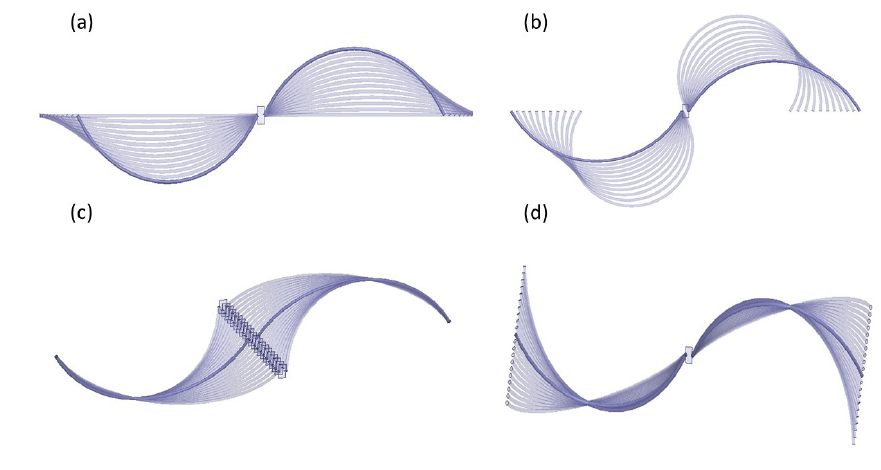
Figure 4. Schematic representation of the induced deformations applied to the spiral fiber antenna: ( a ) stretching, ( b ) compressing, ( c ) bending, and ( d ) folding. Simulations were performed using